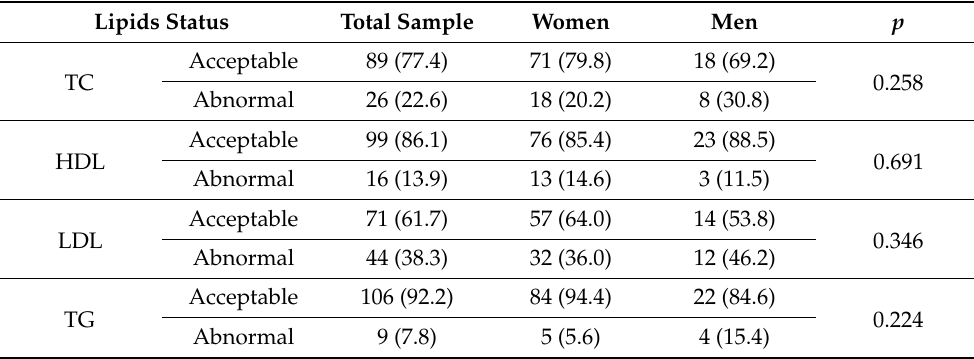
Table 4. Prevalence of abnormal blood lipid values.